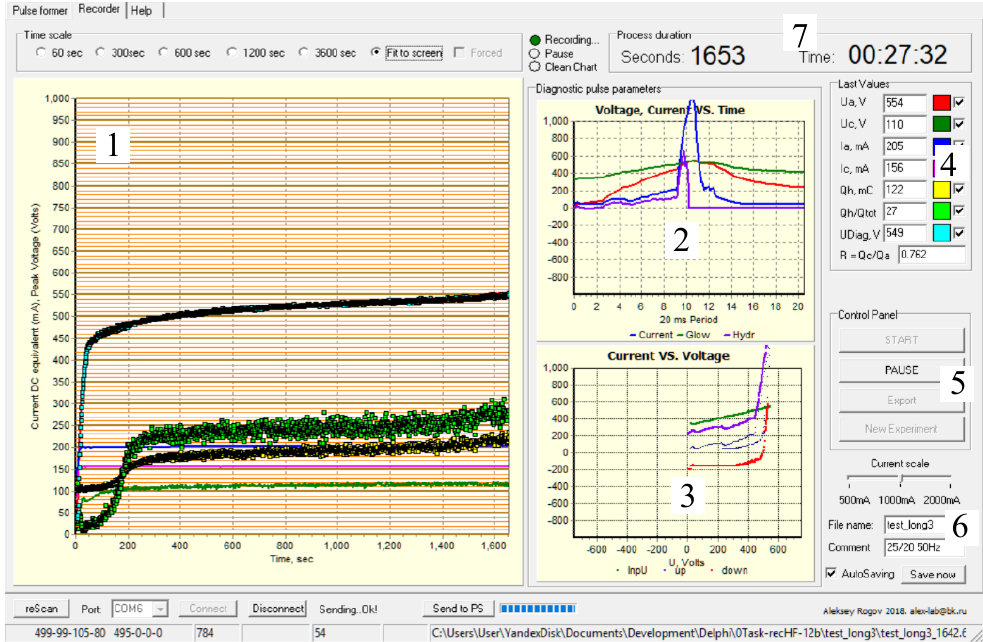
Figure 10. Appearance of monitoring software. Legend: 1—process time chart of anodic and cathodic voltages and currents, as well as additional process parameters calculated from this data; 2—diagnostic pulse waveform; 3— XY graph of diagnostic pulse as current–voltage characteristics; 4—numerical values of measured parameters (Ua,Uc—anodic and cathodic voltages; Ia,Ic—anodic and cathodic currents; Qh—absolute value of asymmetric charge (see below); Qh/Qtot—percentage of asymmetric charge with respect to the total charge within the diagnostic pulse); 5—process controls; 6—waveform auto save settings; 7—timer.